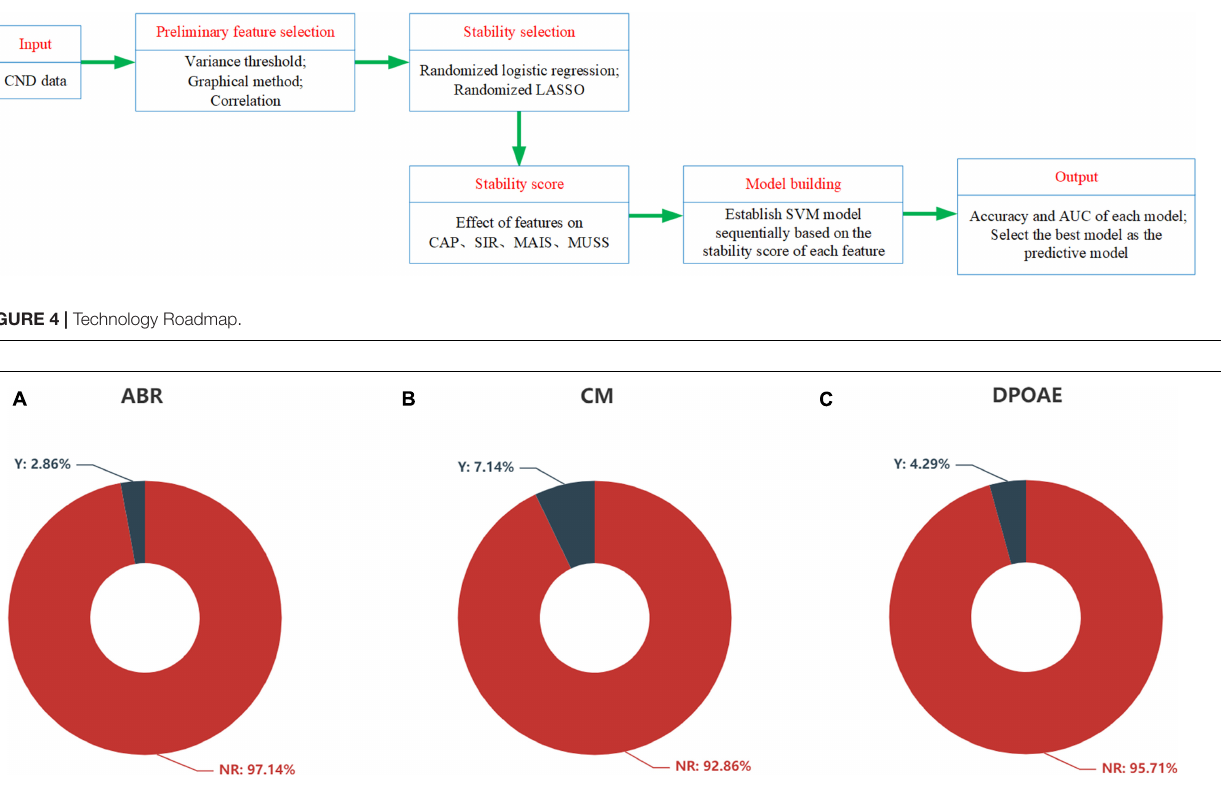
FIGURE 5 | Feature distribution of (A) ABR, (B) CM, and (C) DPOAE according to auditory response. ABR, auditory brainstem response; CM, cochlear microphonics; DPOAE, distortion product otoacoustic emission; Y, response; NR, no response.